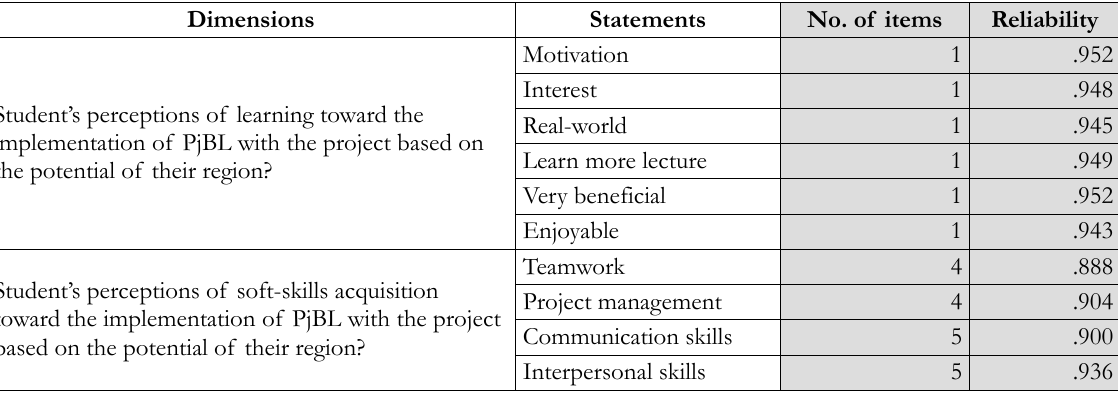
Table 1. Dimensions statement Cronbach’s alpha coefficients of students’